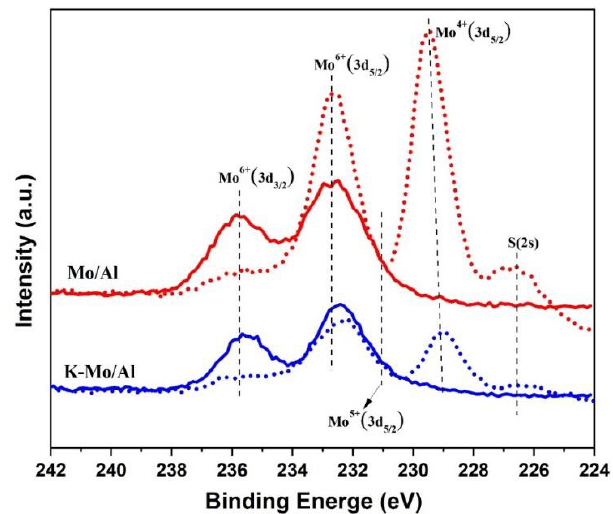
Figure 8. Mo(3d) XPS spectra of the fresh catalysts (Solid line) and the spent catalysts (Dashed